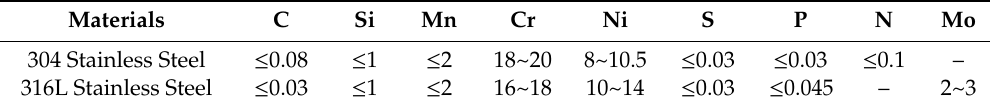
Table 1. Chemical composition (mass fraction / %) of base metal and welding wire.